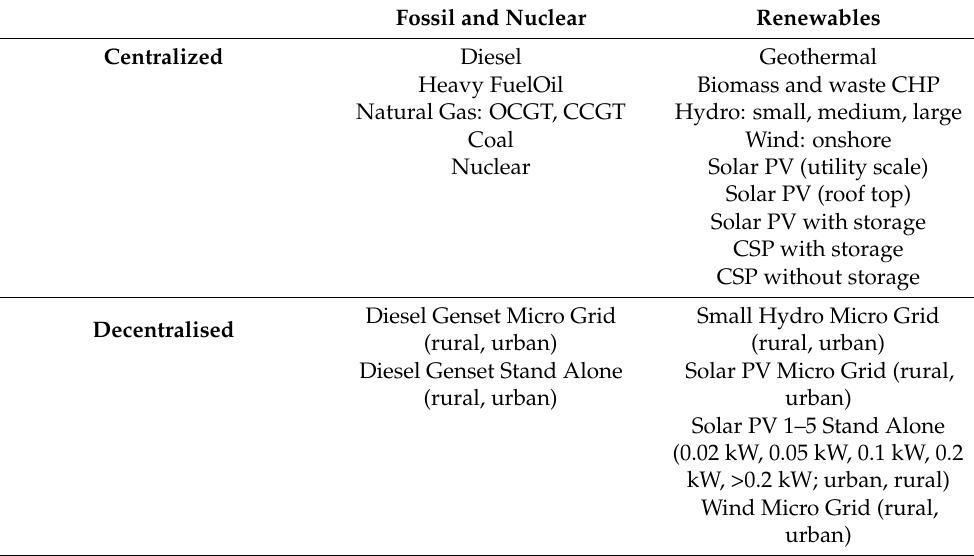
Table 1. List of centralized and decentralized technologies included in the model [28]. Fossil and Nuclear Renewables Centralized Diesel Geothermal Heavy FuelOil Biomass and waste CHP Natural Gas: OCGT, CCGT Hydro: small, medium, large Coal Wind: onshore Nuclear Solar PV (utility scale) Solar PV (roof top) Solar PV with storage CSP with storage CSP without storage Diesel Genset Micro Grid Small Hydro Micro Grid Decentralised (rural, urban) (rural, urban) Diesel Genset Stand Alone Solar PV Micro Grid (rural, (rural, urban) urban) Solar PV 1–5 Stand Alone (0.02 kW, 0.05 kW, 0.1 kW, 0.2 kW, >0.2 kW; urban, rural)